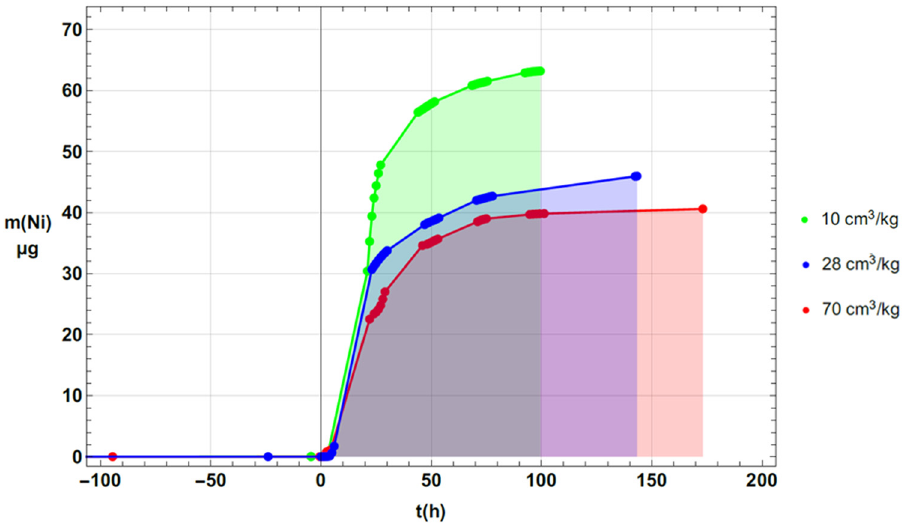
Fig. 14. DUPLEX experiments (cid:2) Ni mass deposited on the core cell for various DH